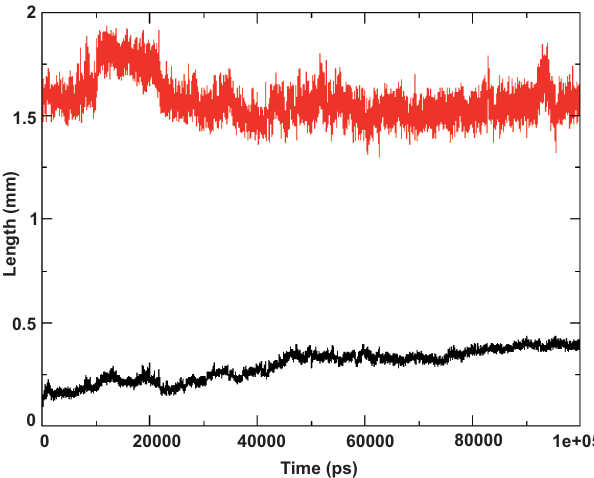
Figure 2. Helix length and RMSD of I-Tasser model. Both amphipathic regions and transmembrane domain located in the hydrophobic core of the bilayer. Length of helix (residues 689–703) is plotted in red, root mean square deviation of the same residues with respect to the starting structure is plotted in